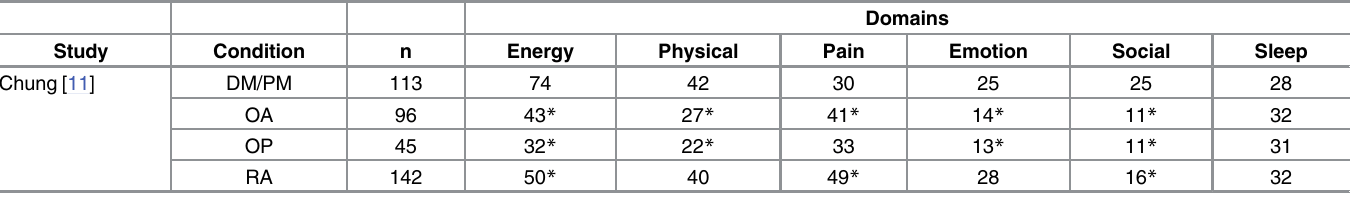
Table 3. Comparison of HRQoL between IIM and other rheumatologic diseases using the NHP.